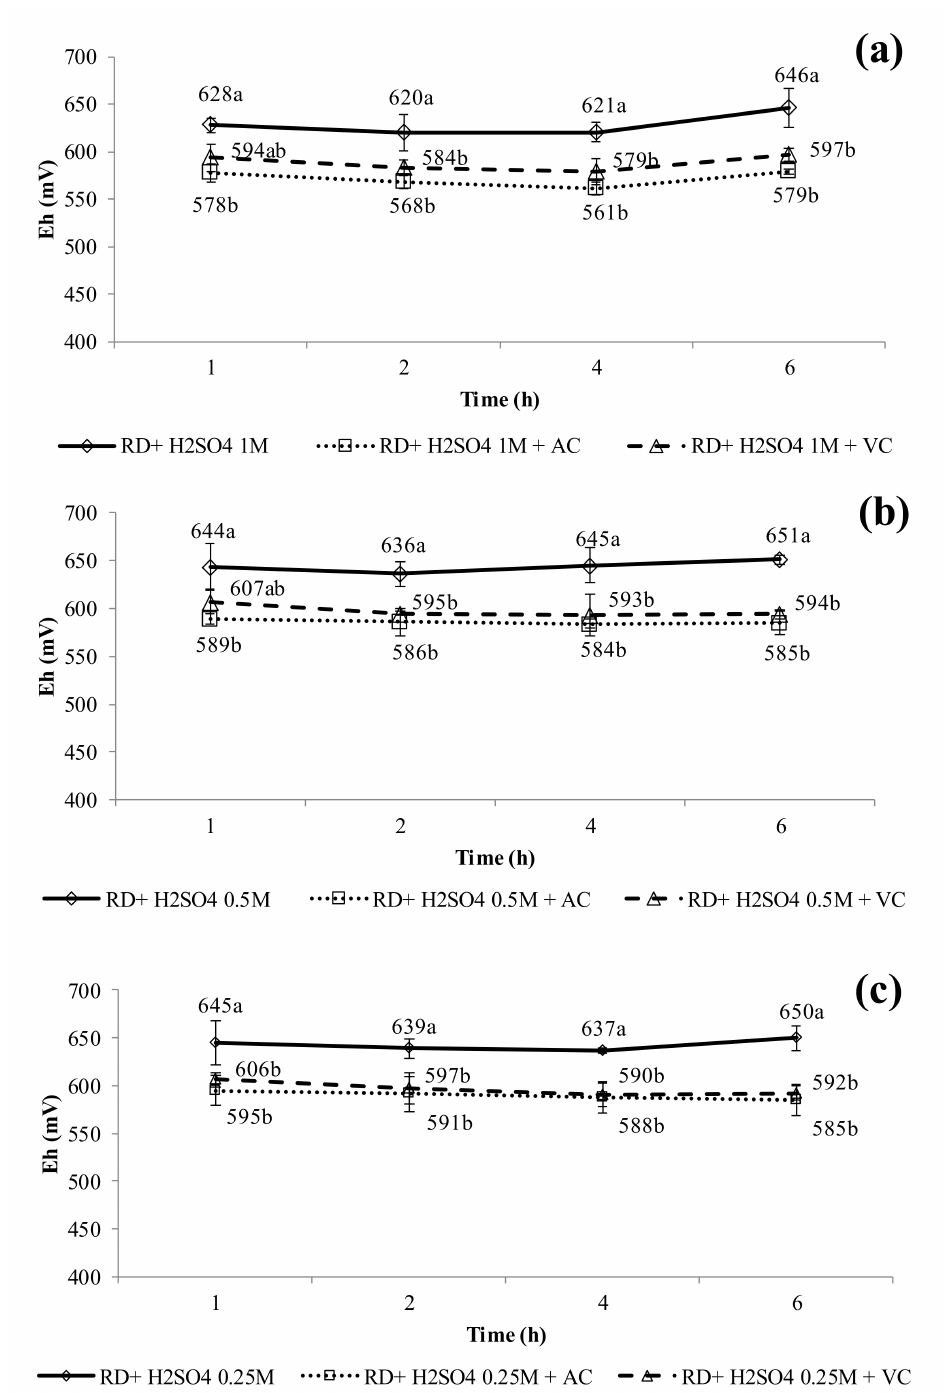
Figure 2. Eh (mV) evolution in samples with H 2 SO 4 1 M, (2.a); H 2 SO 4 0.5 M (2.b) and H 2 SO 4 0.25 M (2.c). Values in dot for each hour followed by the same letter are not significantly different ( p = 0.05) using the Duncan test with a R 2 = 0.73 ( a ), R 2 = 0.84 ( b ) and R 2 = 0.71 ( c ). Error bars indicate standard errors of the mean (n =